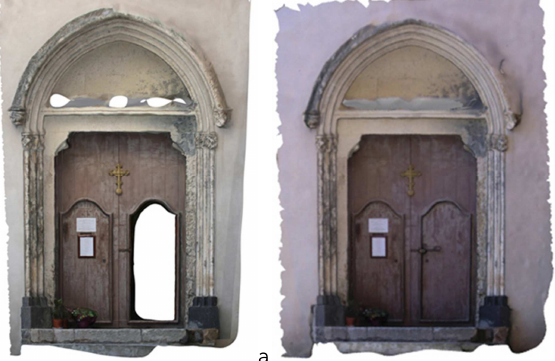
resolution model1 have 35234 faces and model2 70248 faces.